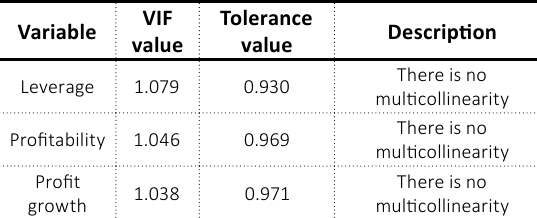
Table 3. Multicollinearity test